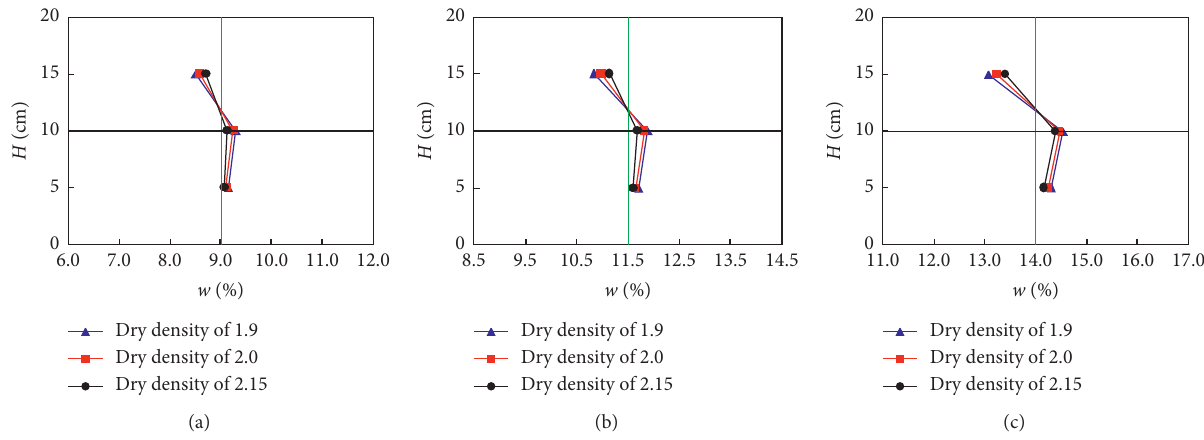
Figure 14: Distribution of moisture content in different positions of soil specimen. (a) w � 9.0%. (b) w � 11.5%. (c) w � 14.0%.